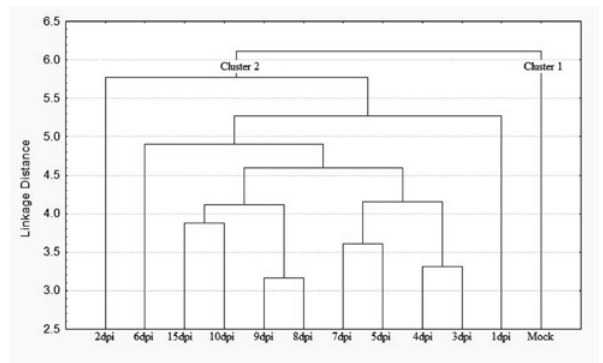
Figure 2. Dendrogram showing the genetic relationships between mock-inoculated and Iris yellow spot virus -infected onion samples at 1, 2, 3, 4, 5, 6, 7, 8, 9, 10 and 15dpi, based on DD-PCR banding patterns with 11 primers. Pairwise genetic comparisons and UPGMA cluster analysis of the data matrix was performed by the unweighted pair-group method using the STATICA 5